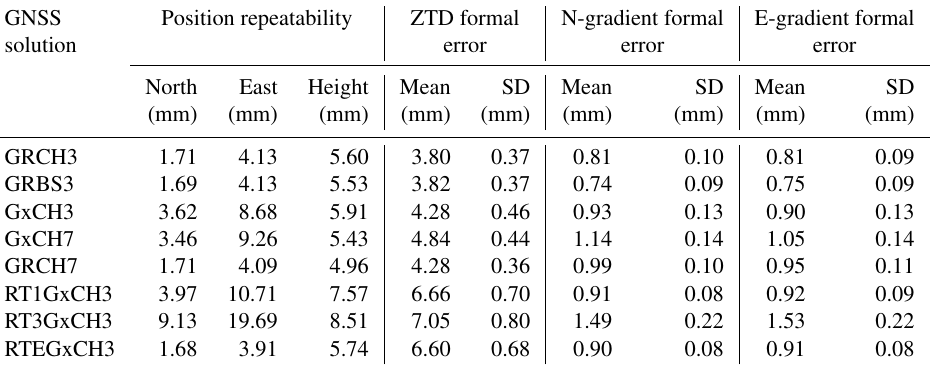
Table 3. Mean position repeatability and formal errors and their standard deviation for tropospheric parameters from individual GNSS processing variants. GNSS Position repeatability ZTD formal N-gradient formal E-gradient formal solution error error error North East Height